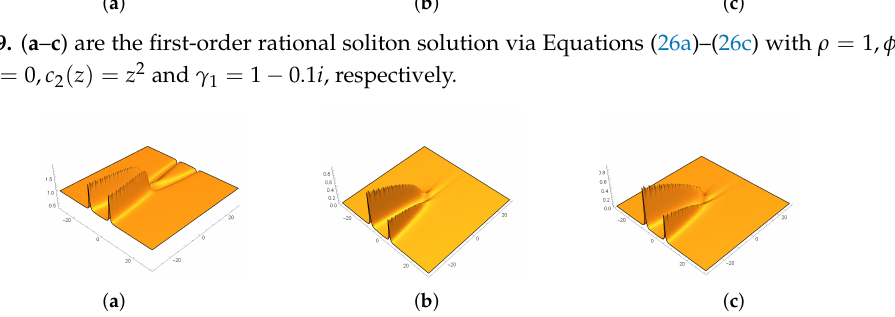
Figure 10. ( a – c ) are the first-order rational soliton solution via Equations (26a)–(26c) with ρ = 1, φ = 0, c 1 ( z ) = 0, c 2 ( z ) = z 2 and γ 1 = 1 − 3 i ,